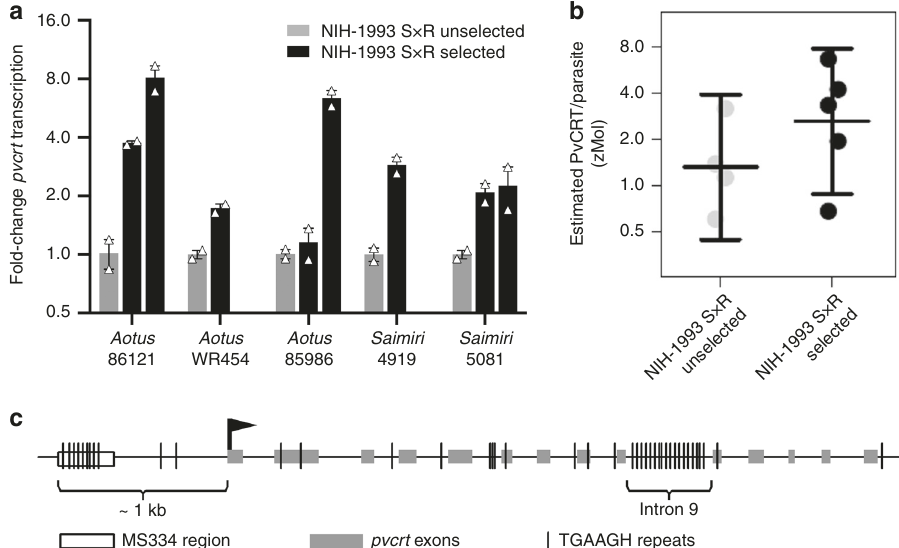
Fig. 3 Evidence for increased pvcrt transcription in CQ-selected P. vivax . a Levels of pvcrt transcription in mixed progeny from the NIH-1993 S × R cross before and after CQ treatment in fi ve different Aotus or Saimiri monkeys. Black bars indicate pvcrt transcription levels in the CQ-selected progeny, normalized to the transcription levels in unselected progeny before CQ treatment (gray bars). Transcription levels were calculated relative to those of the pvseryl-tRNA synthetase ‘ housekeeping ’ gene by the 2 − ΔΔ cT method 63 . PCR determinations for the calculations were performed in duplicate. Thawed samples of cryopreserved parasitized erythrocytes were used in all experiments, thereby enriching for ring-stage parasites and reducing potential variations from older parasite stages. A single post-CQ selection sample was collected from Aotus WR454 and from Saimiri 4919; post-CQ treatment samples were collected on two different days from each of Aotus 86121, Aotus 85986, and Saimiri 5081. Error bars indicate standard deviations from two technical replicates shown as white triangles in the graph. b Estimated PvCRT protein concentration per parasitized erythrocytes in monkey blood samples infected with from NIH-1993 SR unselected (gray) and selected (black) progeny. Points for each strain are the estimated levels, and lines represent geometric means and the associated 95% con fi dence intervals from 5 or 6 biologically independent samples. zMol zeptomole. c Schematic of the P. vivax chromosome 1 segment containing the exons, introns, and untranslated fl anking regions of pvcrt . Multiple repeats of the TGAAGH motif occur in MS334 and intron 9. F9 indicates the region from exon 9 where the sequence of forward primer used to perform qRT-PCR is located and R11 the region where the sequence of the reverse primer is located (see the “ Methods ” section). The asterisk indicates where codons of the peptide used for MRM analysis